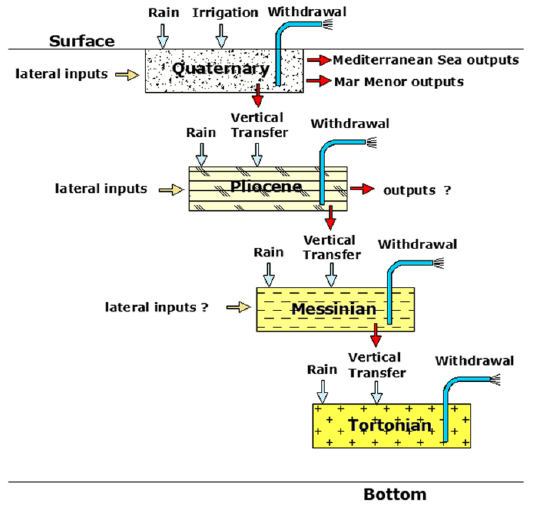
Figure 3. The conceptual model for Campo de Cartagena.